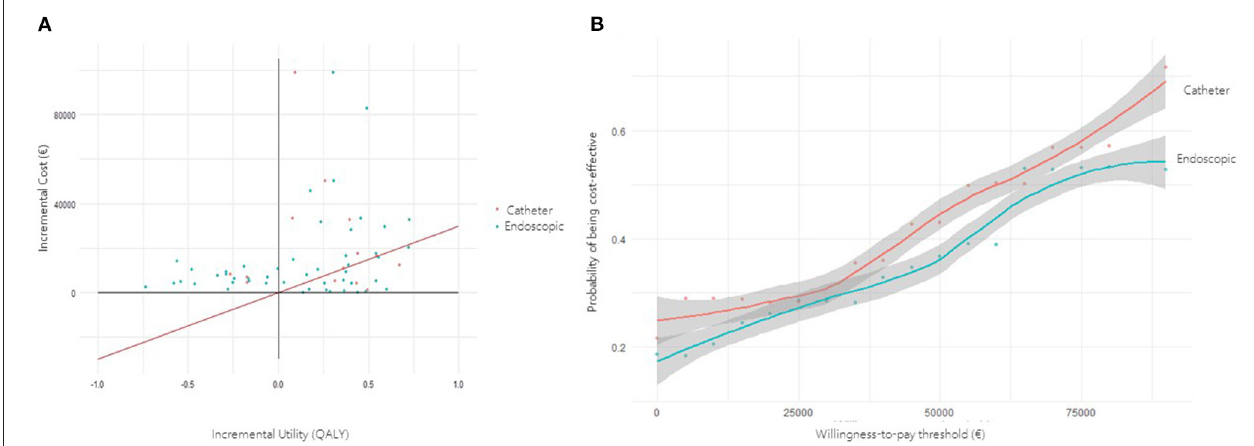
FIGURE 1 | (A) Incremental cost-utility scatter plot. Each point represents a simulation of a real-life case treated with minimally invasive (MIS) hematoma evacuation. Catheter-based replicates are represented in red, whereas endoscopic replicates are in blue. The diagonal red line represents the willingness-to-pay threshold of e 30,000 per QALY; points situated to the right of this theoretical threshold are considered cost-effective. (B) Cost-utility acceptability curve. The curve presents the probability of MIS being cost-effective at any given willingness-to-pay